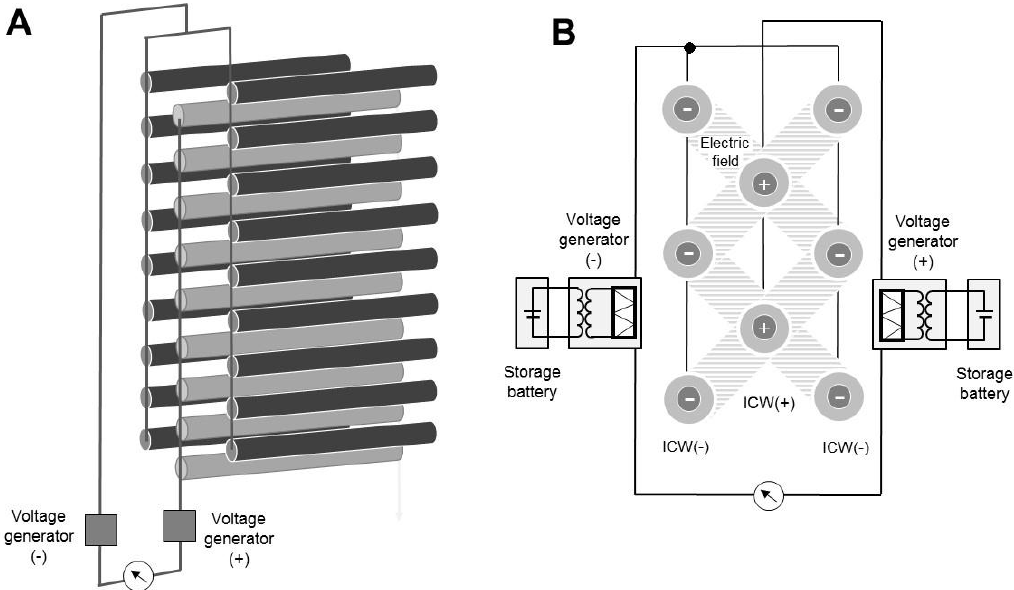
Figure 1. Structure ( A ) and cross-sectional view ( B ) of the three insulated conductor wire (ICW) layers of the electrostatic-barrier-forming window (EBW).